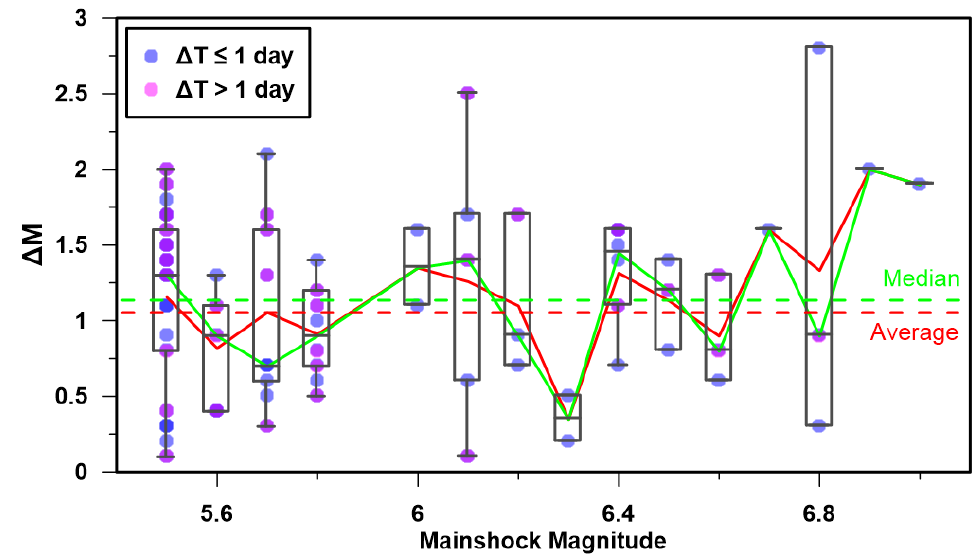
Figure 5. Magnitude difference ( ∆ M) between the mainshock and its largest aftershock. Dashed green and red lines correspond to the median and average ∆ M, respectively.